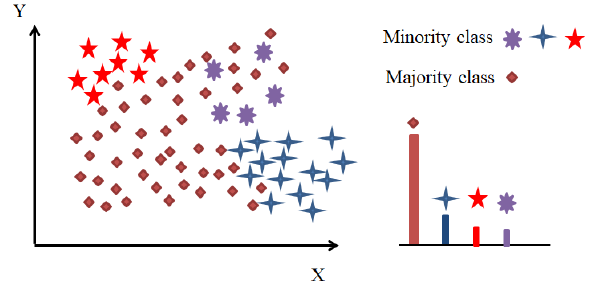
Figure 1. A case of unbalanced data.